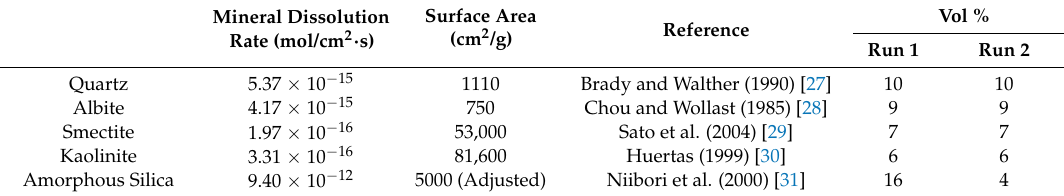
Table 2. Mineral dissolution rates and surface areas of silica-bearing phases loaded in the geochemical modeling as